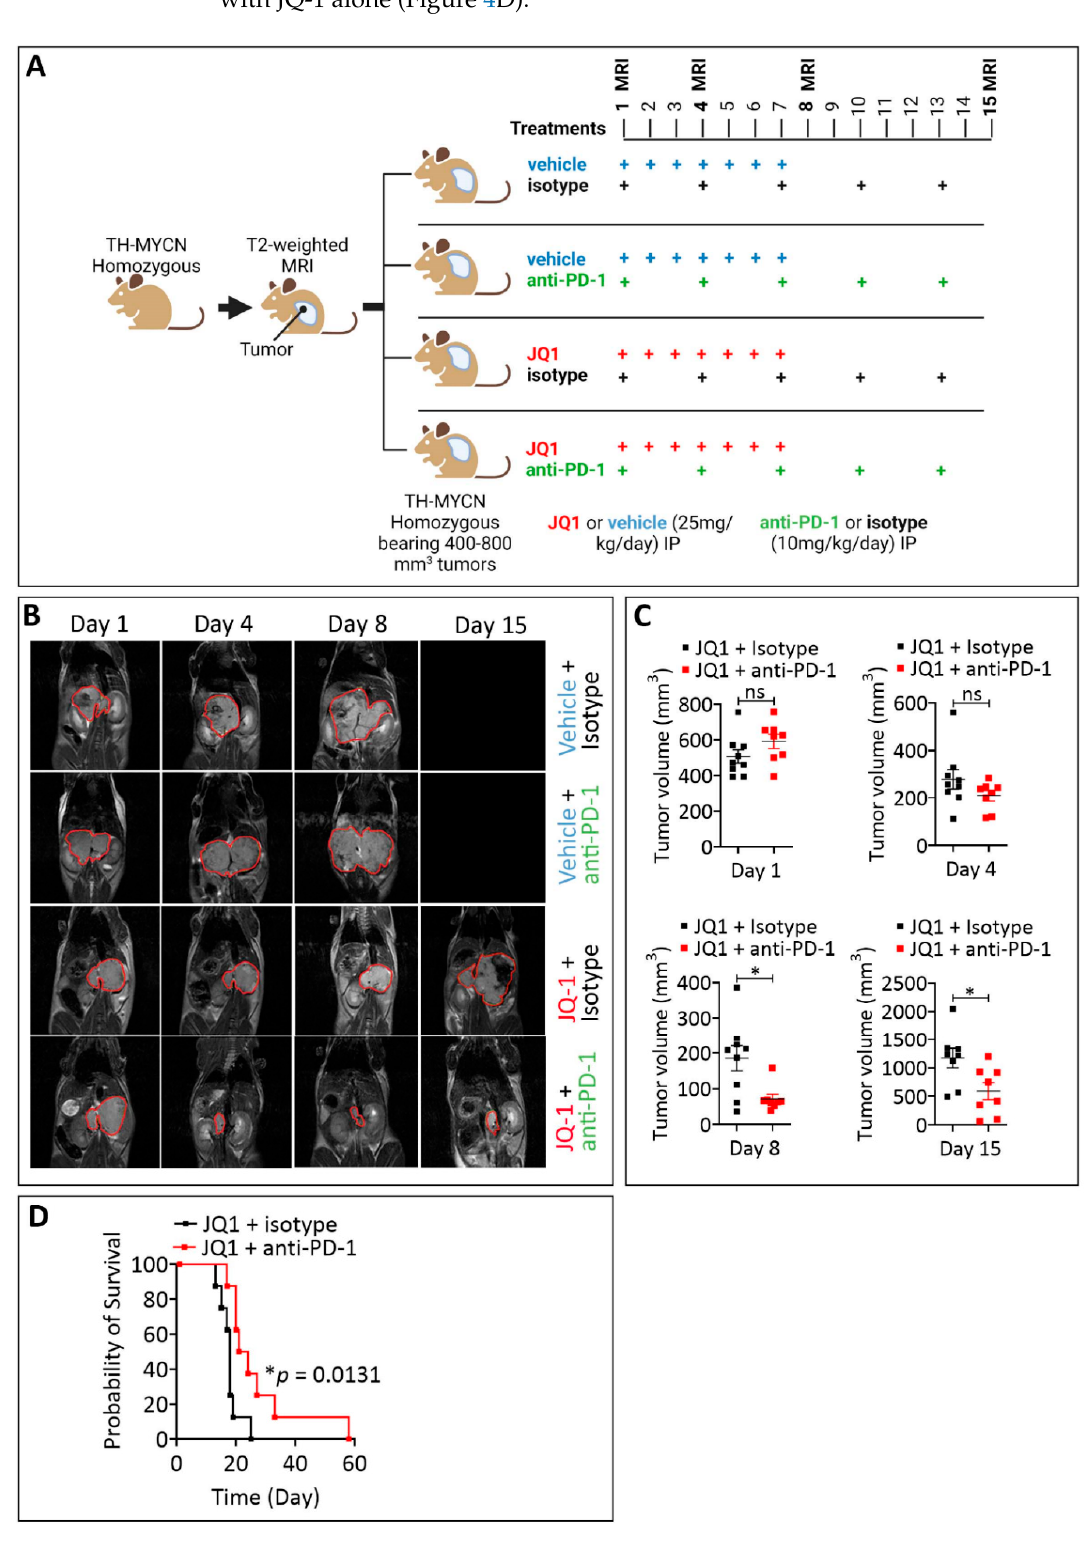
Figure 4. Impact of combining JQ1 and PD-1 on TH-MYCN tumor volume and mice survival. ( A ) Experimental design of JQ1 and anti-PD-1 treatment of TH-MYCN tumor-bearing mice showing the schedule and dosing. Following the development of homozygote